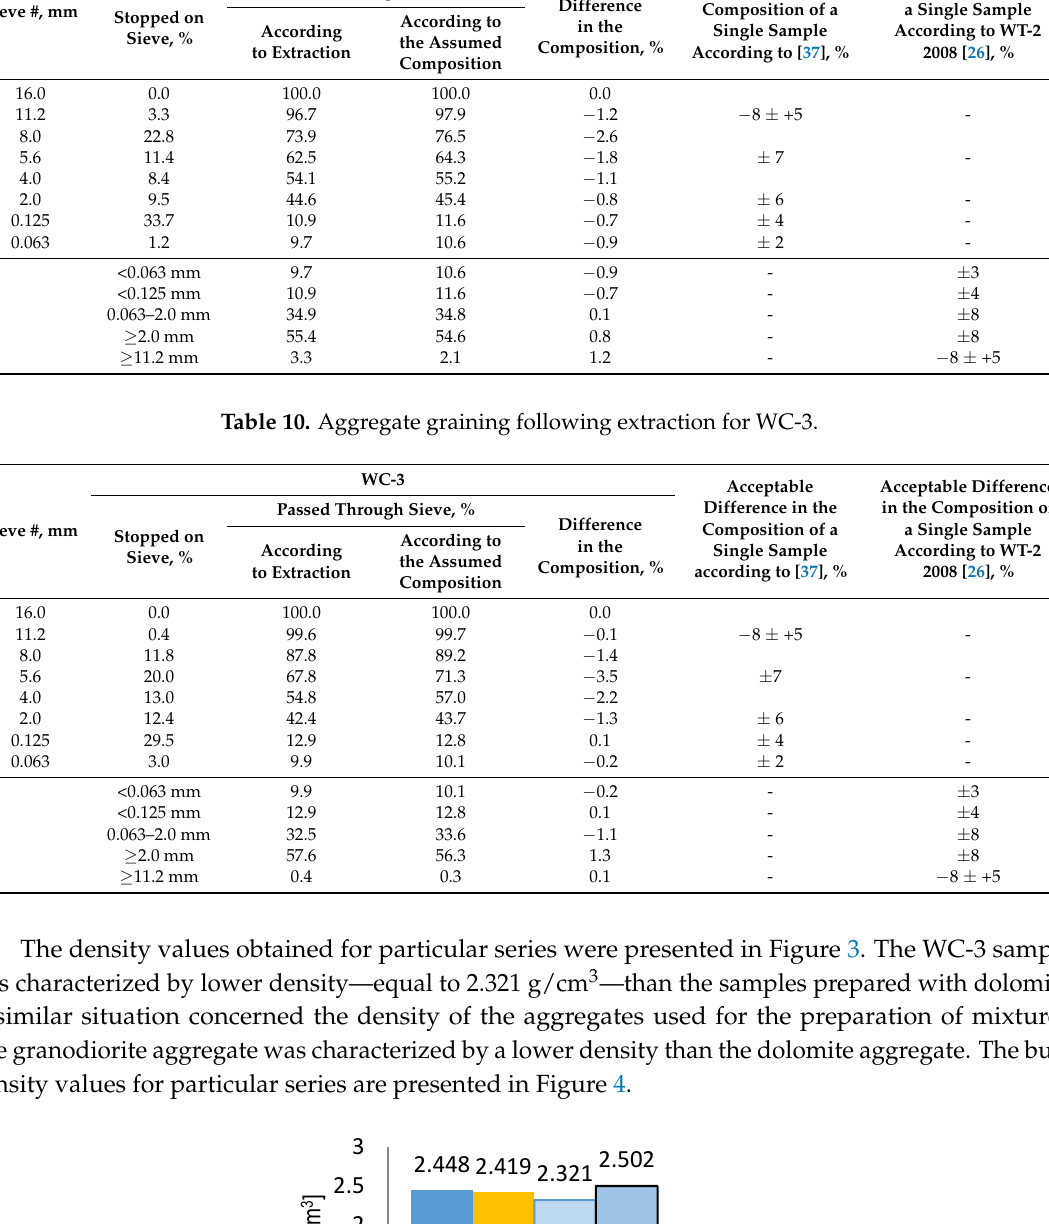
Figure 4. Bulk density of mineral-asphalt mixtures. A sample of mineral-asphalt mixture prepared with granodiorite was characterized by a lower bulk density, amounting to 2.256 g/cm 3 , than the samples prepared with dolomite. The void content calculations results in a mineral-asphalt mixture for particular series are presented in Table 11. Table 11. Content of voids in MAM for particular series, %. WC-1 WC-2 WC-3 WC-4 Content of voids in MAM, (%)